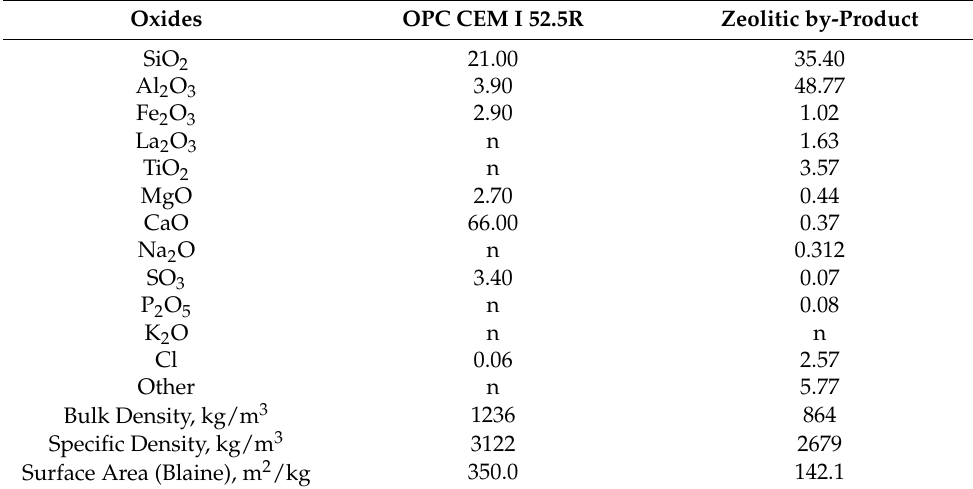
Table 1. Chemical composition of the zeolitic by-product,